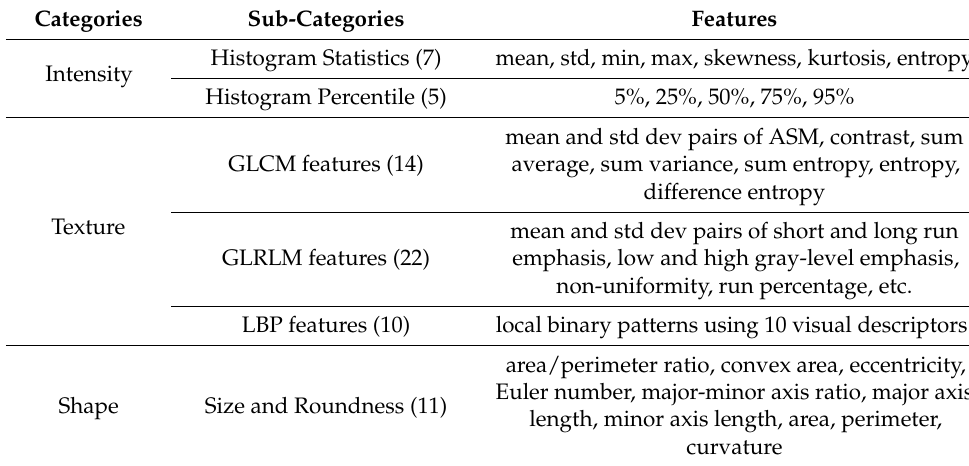
Table 2. List of radiomic features used in this